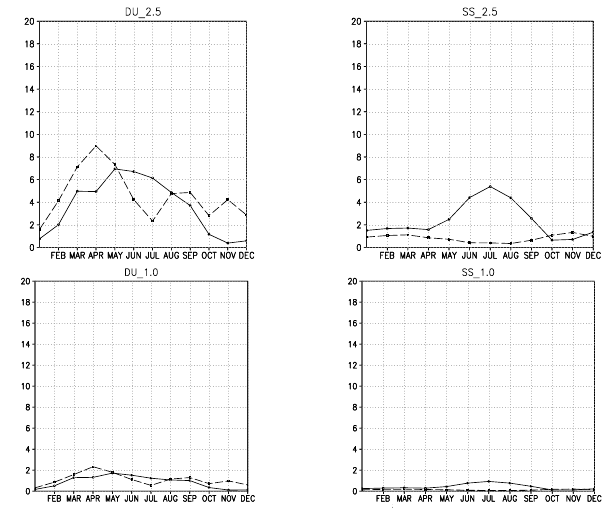
Fig. 9. Contributions of mineral dust and sea salt to the four-year mean surface mass concentration in size classes PM 2 . 5 and PM 1 . 0 for China (dashed line) and India (solid line), in units µgm − 3 , four- year average